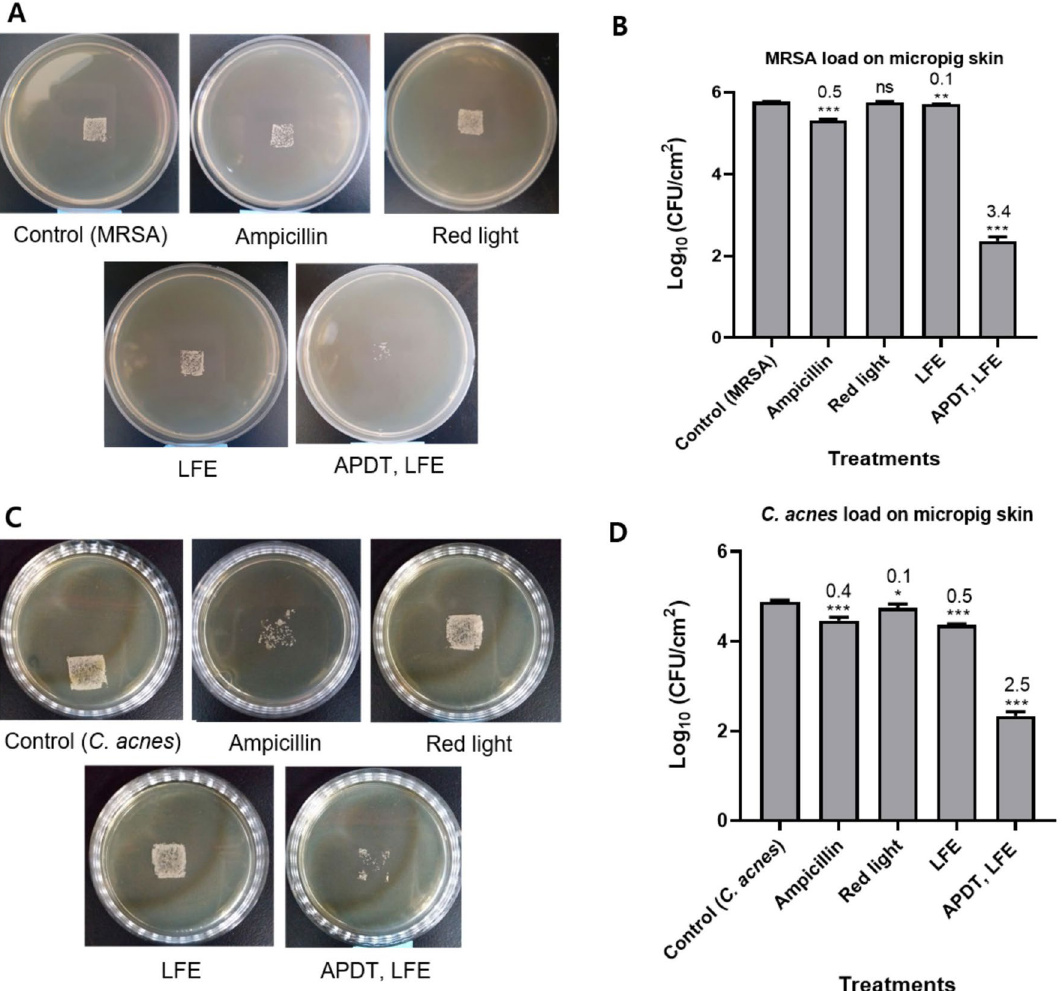
Fig. 8 APDT effects against MRSA and C. acnes with LFE on micropig skin. Overnight culture of MRSA or C. acnes was incubated with or without LFE (20 µg/mL; 30 min incubation) and spread on the micropig skin at 5 µL/cm 2 . Ampicillin (100 µg/mL) was used as a positive control. The coated skin was then illuminated under red light at 20 W/m 2 for 30 min. The treated skin was imprinted on BHI agar to illustrate the inhibition of C. acnes or MRSA on the surface of the skin by APDT. Representative images of MRSA growth on LB plates ( A ) and C. acnes growth on BHI plates ( C ) were recorded after 48‑hour incubation. The differently treated skins were also washed with phosphate‑buffered saline using a swab. The total content of bacteria on the swab of each treatment was plated on LB or BHI agar plates. B , D ) CFU formation after 48 h was quantified and represented in the graph as a log (CFU/cm 2 ). The data are reported as mean standard error (n 2) and representative of at least two independences. ns indicates ± = no statistical significance relative to the control group. Significant differences are expressed with * for p < 0.05, ** for p < 0.01, and *** for p < 0.001 relative to the vehicle control. The log reductions compared with vehicle control are presented in each